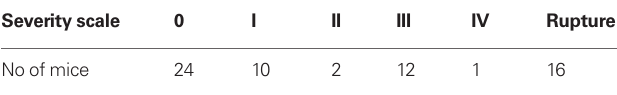
Table 2 | Classification of Ang II-induced aortic